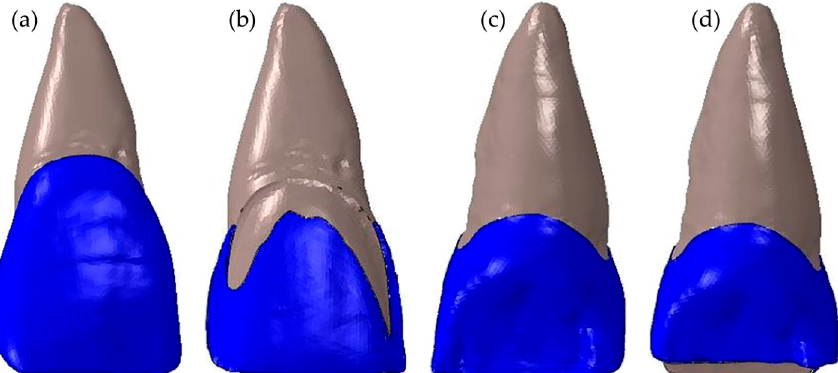
Figure 2. Solid models of ( a ) the sound tooth, ( b ) the butt joint prepared tooth in buccal aspect, ( c ) the